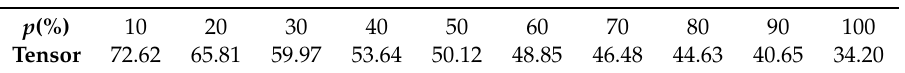
Table 9. (cid:107)G(cid:107)